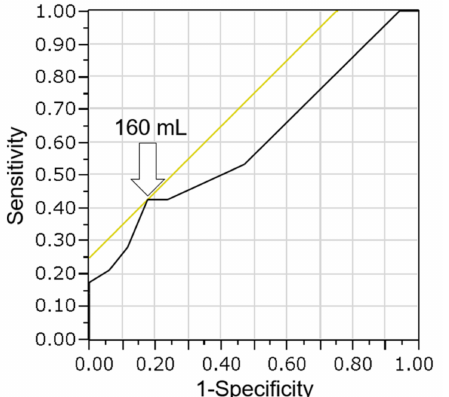
Figure 6. Receiver operating characteristic curve analysis of bile volume and diagnosis of malignancy using the cell block method. The optimal cutoff was calculated as 160 mL (arrow), with a sensitivity of 43% and a specificity of 82%. The area under the curve is